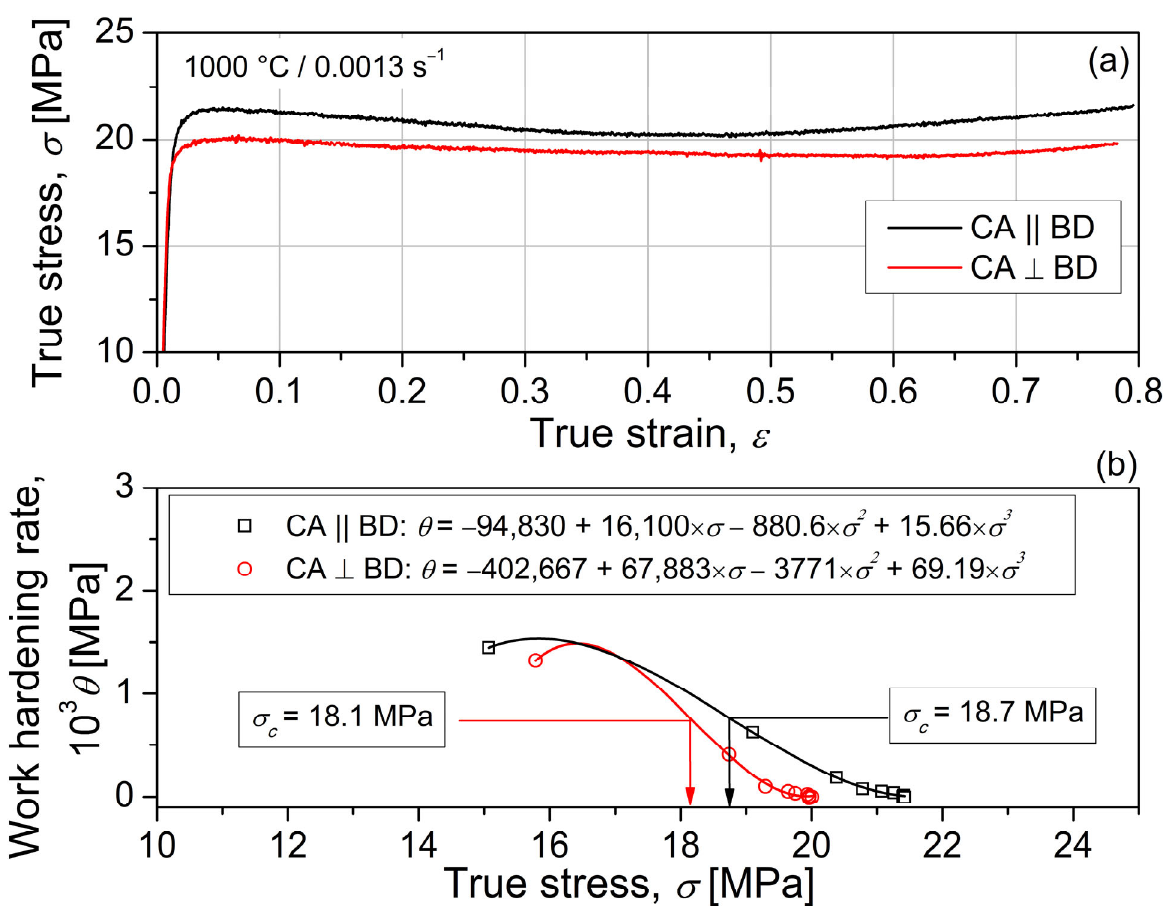
Figure 2. True stress–strain curves ( a ) and strain-hardening rate ( θ ) versus flow stress ( σ ) up to the peak stress ( b ) of LPBF specimens hot compressed at 1000 °C up to a true strain of 0.8 with a strain rate of 0.0013 s − 1 in different directions to the BD. The rise in flow stress after a steady state is due to the dominance of friction and bulging of the specimens at higher strains. The θ − σ curves were fitted by a third-order polynomial, and the relationships between θ and σ were given. The CA and BD refer to the compression axis and building direction in the LPBF process.